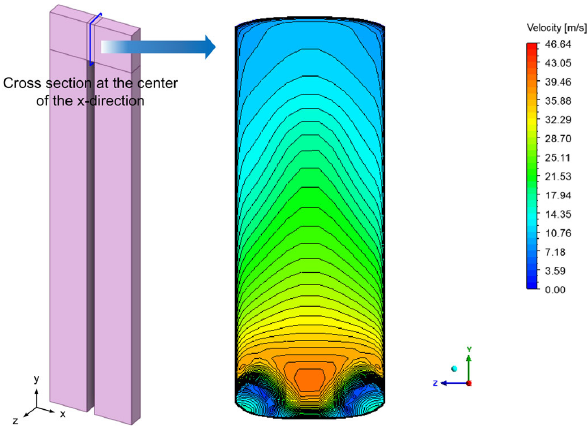
Figure 16. Velocity contour at the center of the x-coordinate using the adjoint solver (Re = 24,230).